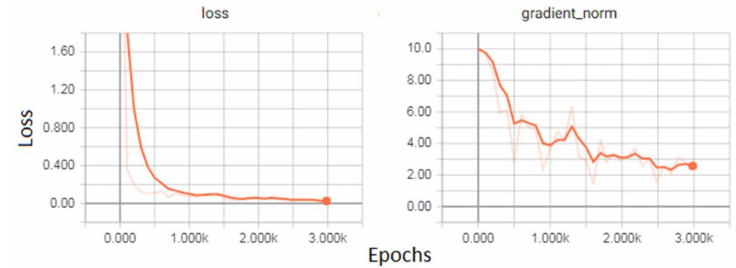
Figure 7. Loss after training of model faster